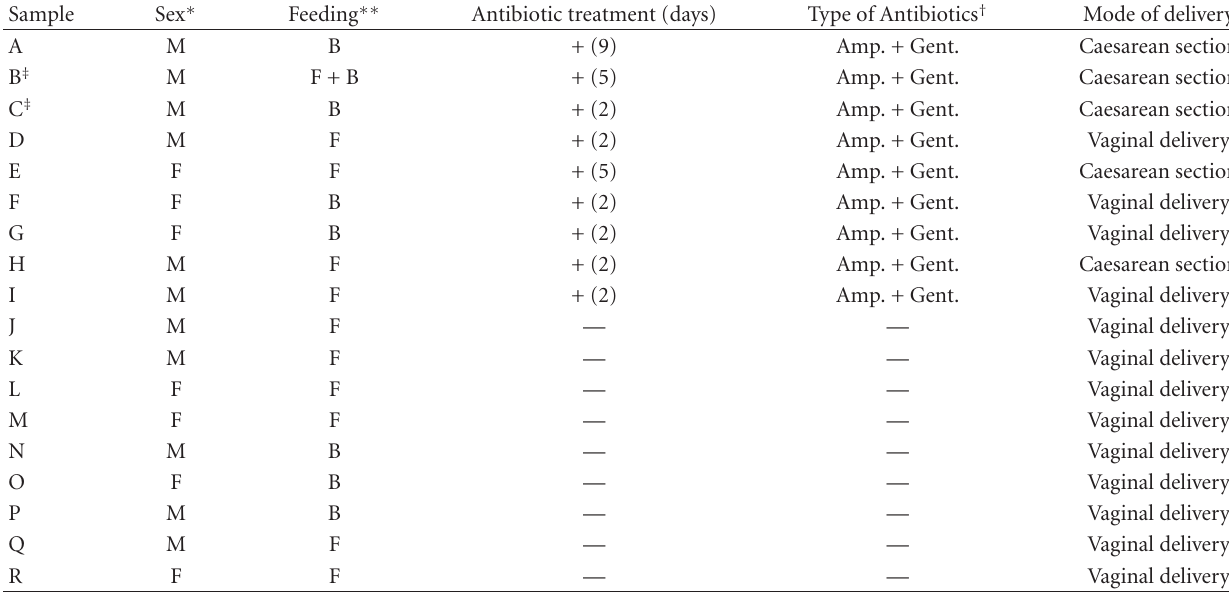
Table 1: Description of infant